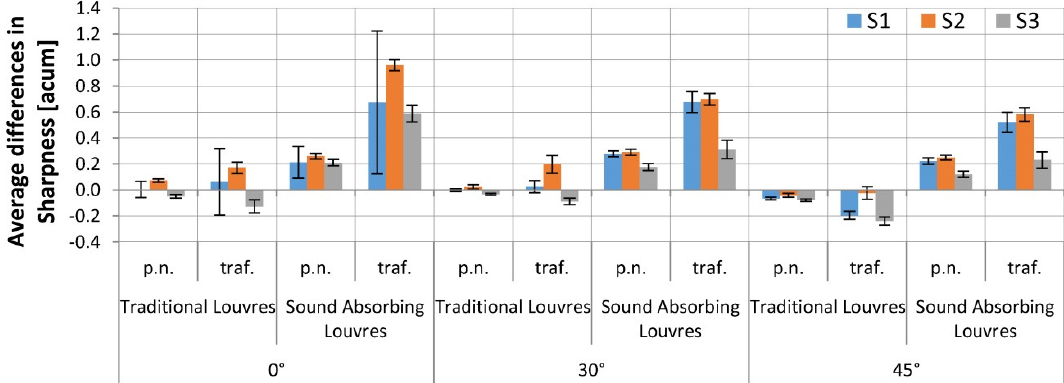
Figure 9. Average differences in Sharpness due to the presence of the traditional louvres compared to the sound absorbing louvres. The bars in the figure are listed according to the source positions used for the measurements (S1, S2, and S3). Error bars report the doubled standard deviations for each average. The acronym “p.n.” refers to the pink noise signal. The abbreviation “traf.” refers to the standard traffic noise.